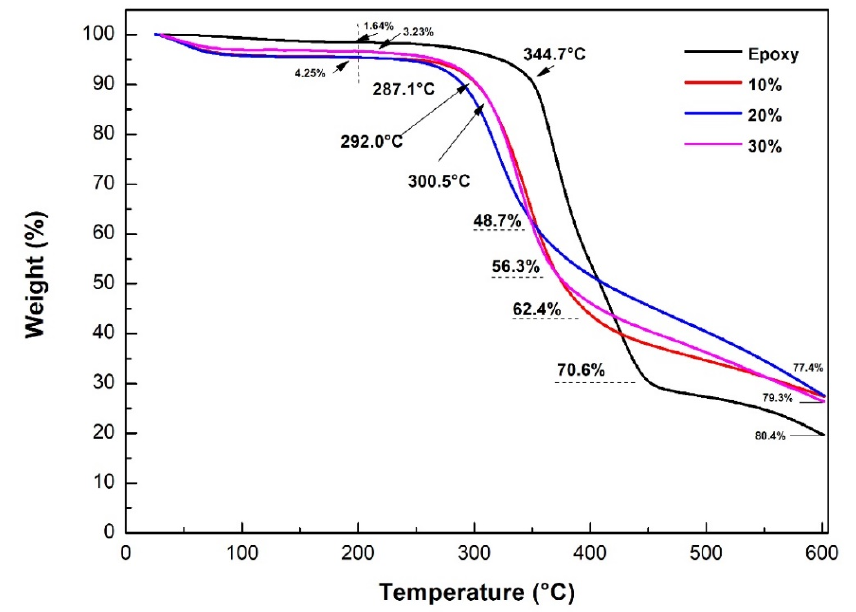
Figure 9. TG curves for the epoxy resin and for the CM sedge fiber-reinforced composites.